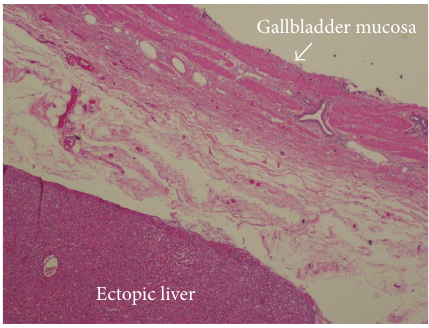
Figure 2: Low power histological image of gallbladder tissue and ectopic liver tissue.